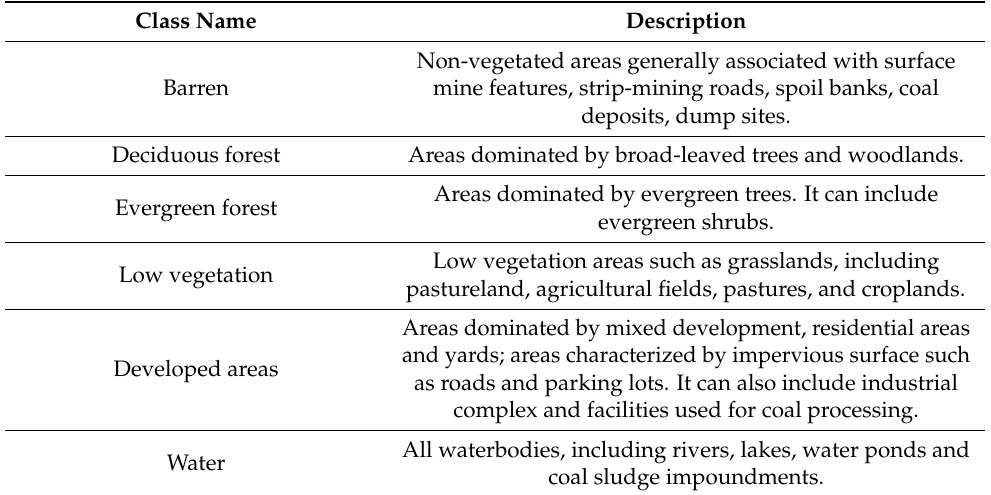
Table 1. The 1976 land cover classes definition.